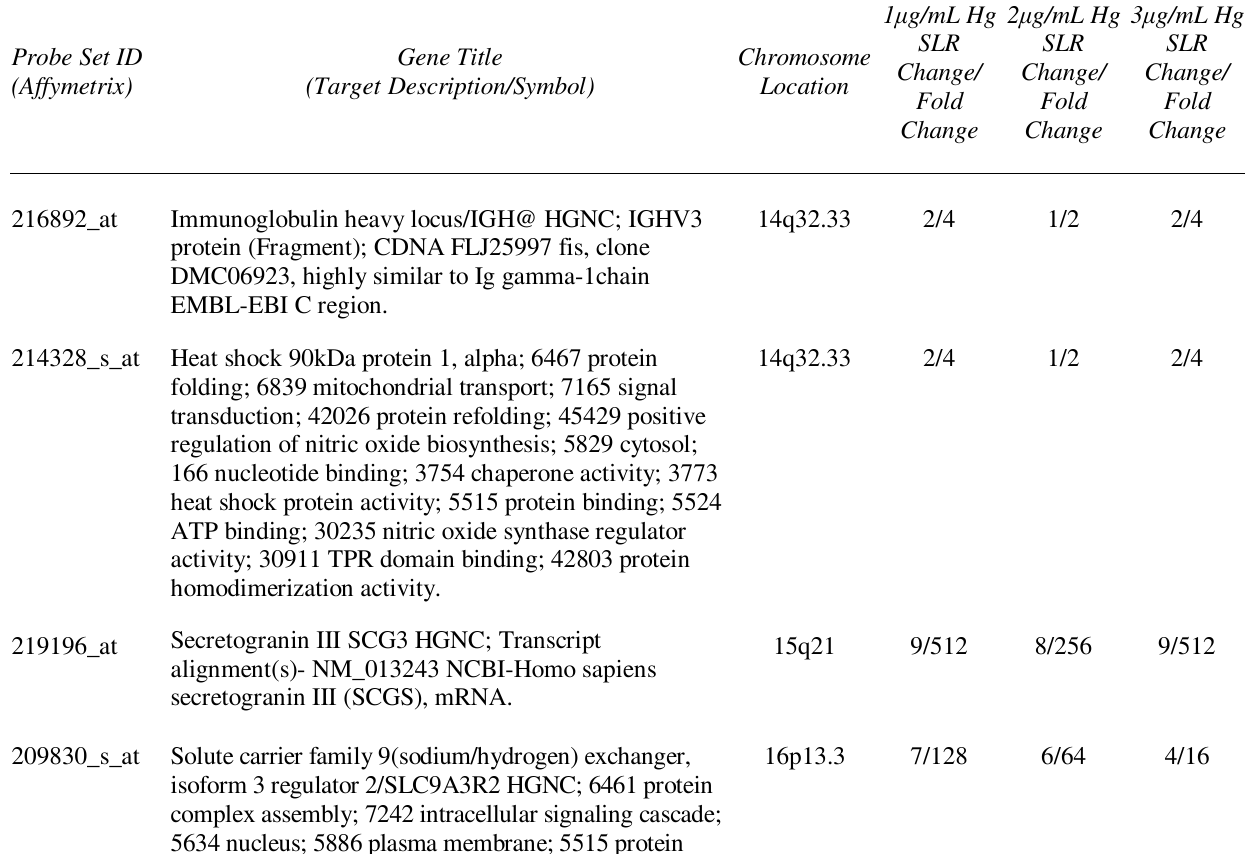
Table 1 contd.: Sample genes affected by mercury.